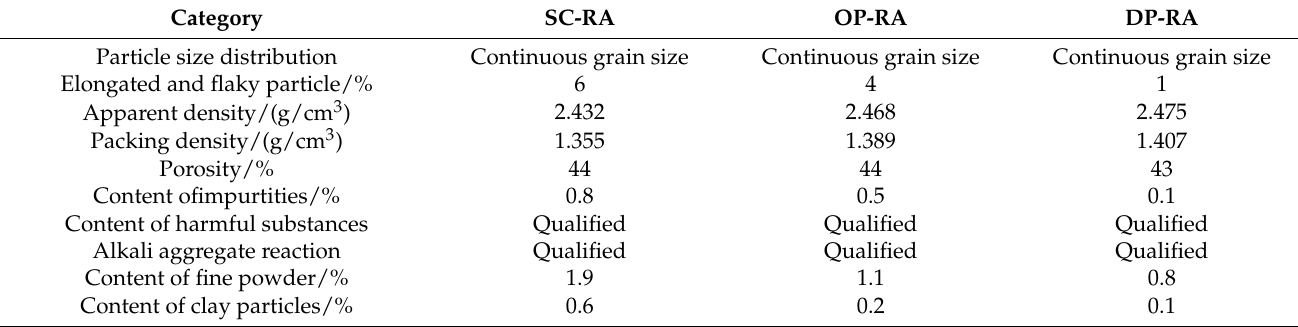
Table 3. Basic performance indices of recycled coarse